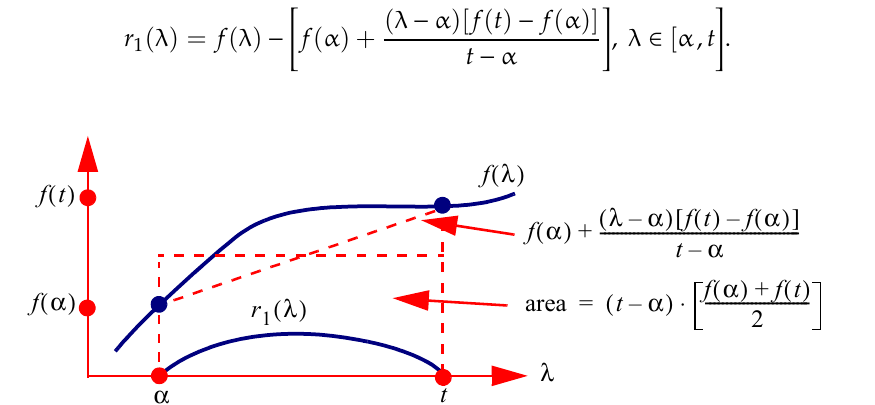
Figure 7. Illustration of the area defined by a zeroth order approximation to an integral and the residual function r 1 .